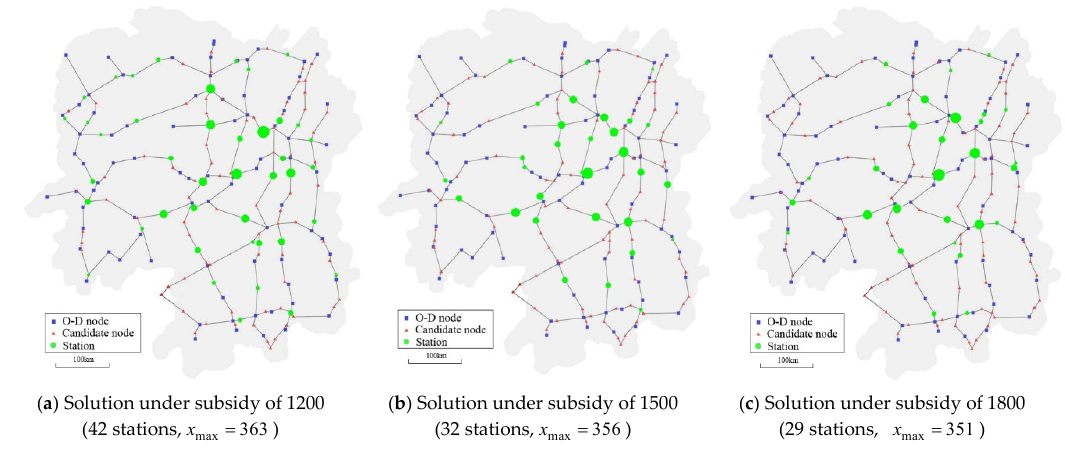
Figure 9. The results under different subsidies.